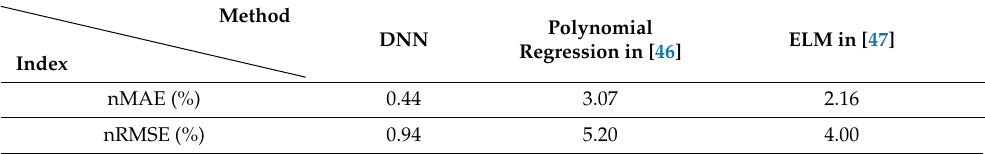
Figure 12. Comparisons of data-fitting performance with irradiance and temperature via DNN, PR and ELM. Table 14. Data-fitting performance index comparisons of DNN, PR in [46] and ELM in [47].